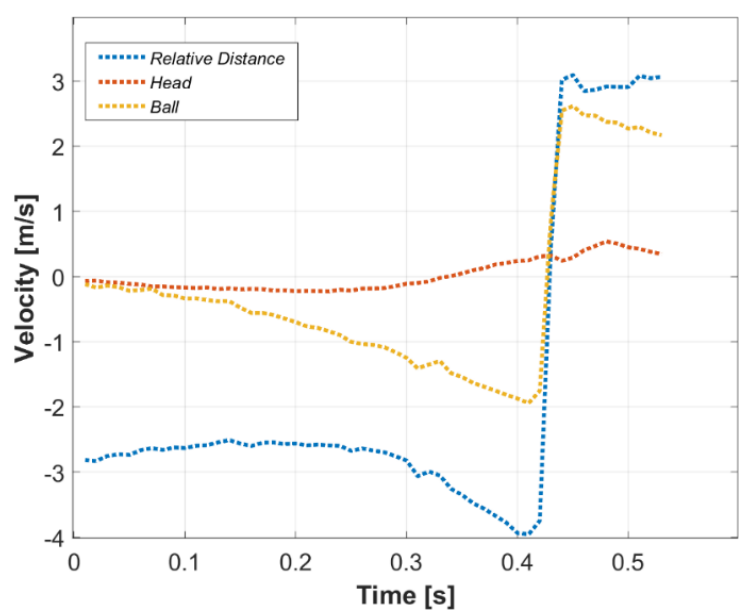
Figure 7. Instantaneous velocity measured using the relative distance between head and ball and position tracking data for head and ball.